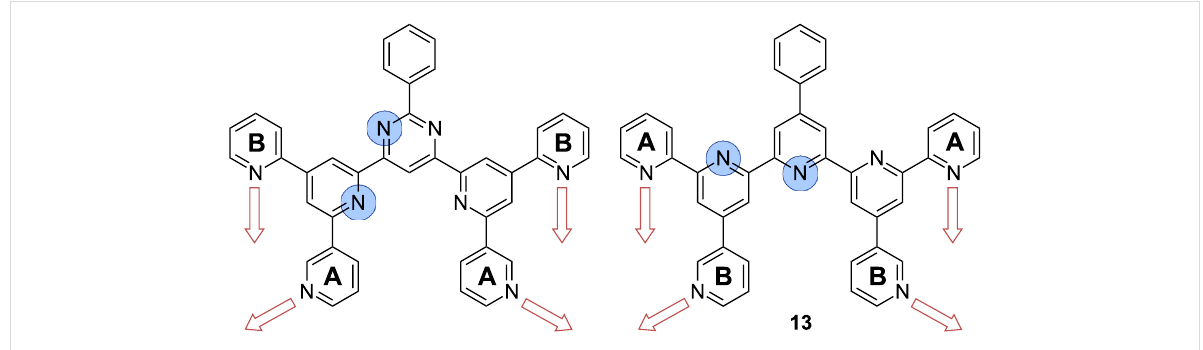
Figure 2: The synthetically unavailable 3,2'-BTP (left), which is representative of the other inaccessible BTPs, is hypothetically derived from the unavailable 3,2'-diazachalcone. The corresponding 2,3'-PhSpPy ( 13 ) (right), derived from the available 2,3'-diazachalcone, should adopt the transoid N–C–C–N conformation [30] in the coplanar adsorbed state and thus the same orientation of the peripheral pyridine units.